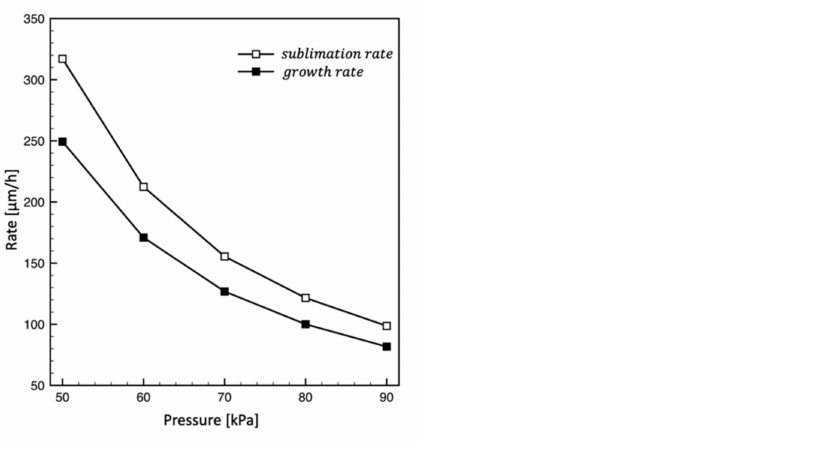
Figure 5. Profiles of the sublimation rate and growth rate under various pressures.